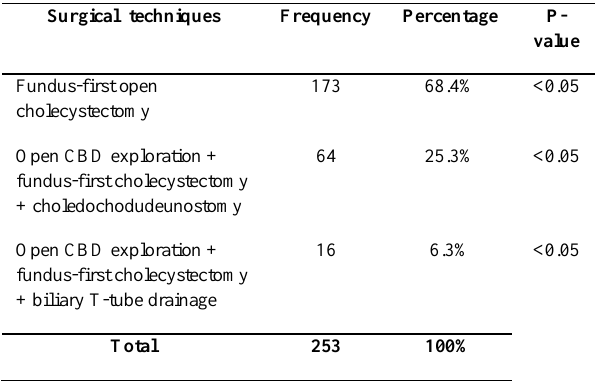
Table 2: Types of surgical techniques used during open cholecystectomy facing intraoperative difficulties